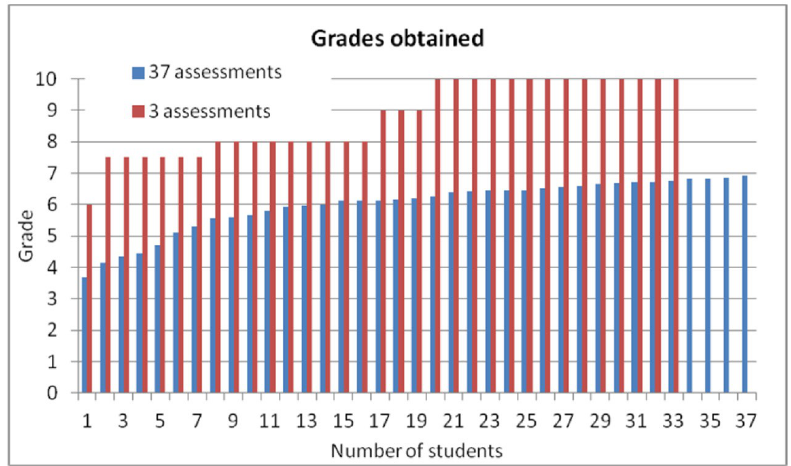
Figure 8. Marks obtained versus number of peer